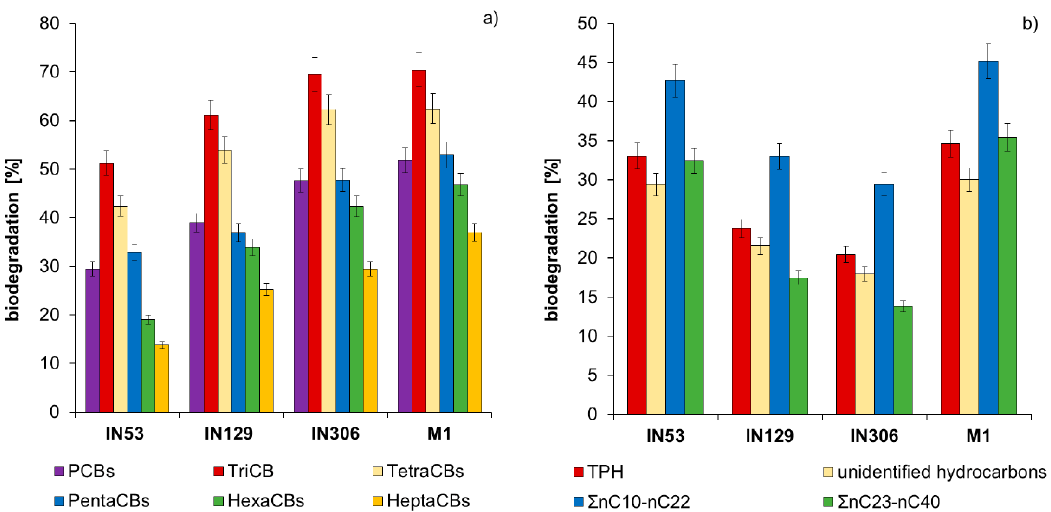
Figure 5. Comparison of biodegradation (%) in sterile Soil C contaminated with both PCBs and TPH after inoculation with Mycolicibacterium frederiksbergense IN53, Rhodococcus erythropolis IN129, Rhodococcus sp. IN306, and mixed culture M1: ( a ) polychlorinated biphenyls; ( b ) petroleum hydrocarbons (repetition number n = 8–10, p < 0.05).